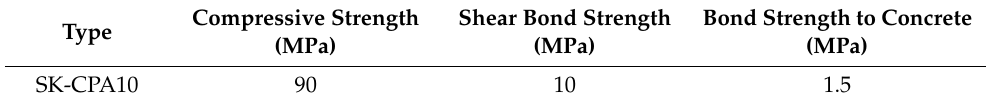
Table 2. Mechanical properties of epoxy resin.